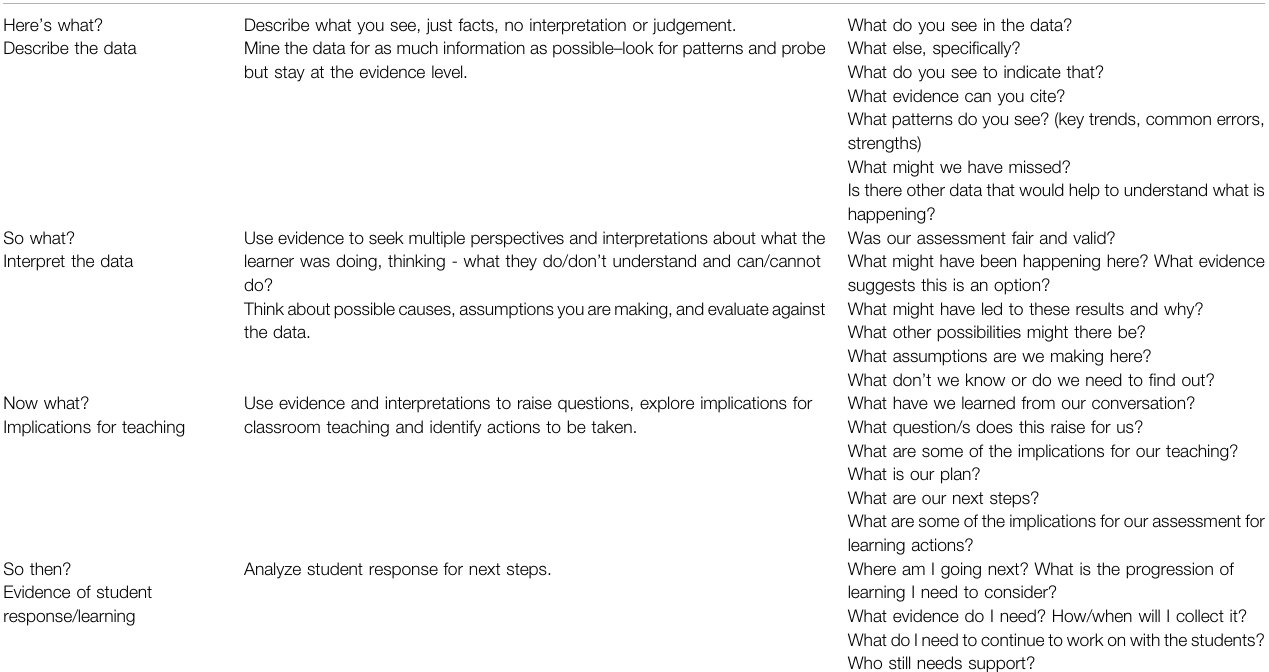
TABLE 1 | Data conversation